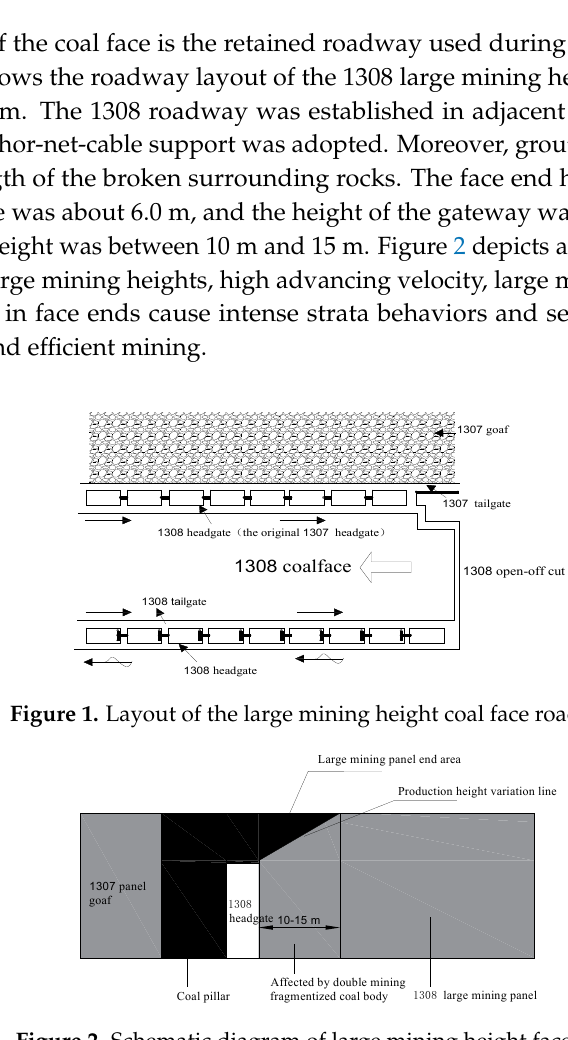
Figure 2. Schematic diagram of large mining height face end.